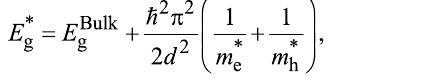
As shown in Figure 5b, the extrapolation of the linear part of the curve to the photon energy axis produces the optical energy gap. The energy gap of Ag 2 S NPs synthesized in Tu and Tu with CTAB was 1.5 and 2 eV, respectively. The energy gap was increased and a blueshift of about 0.5 eV was observed